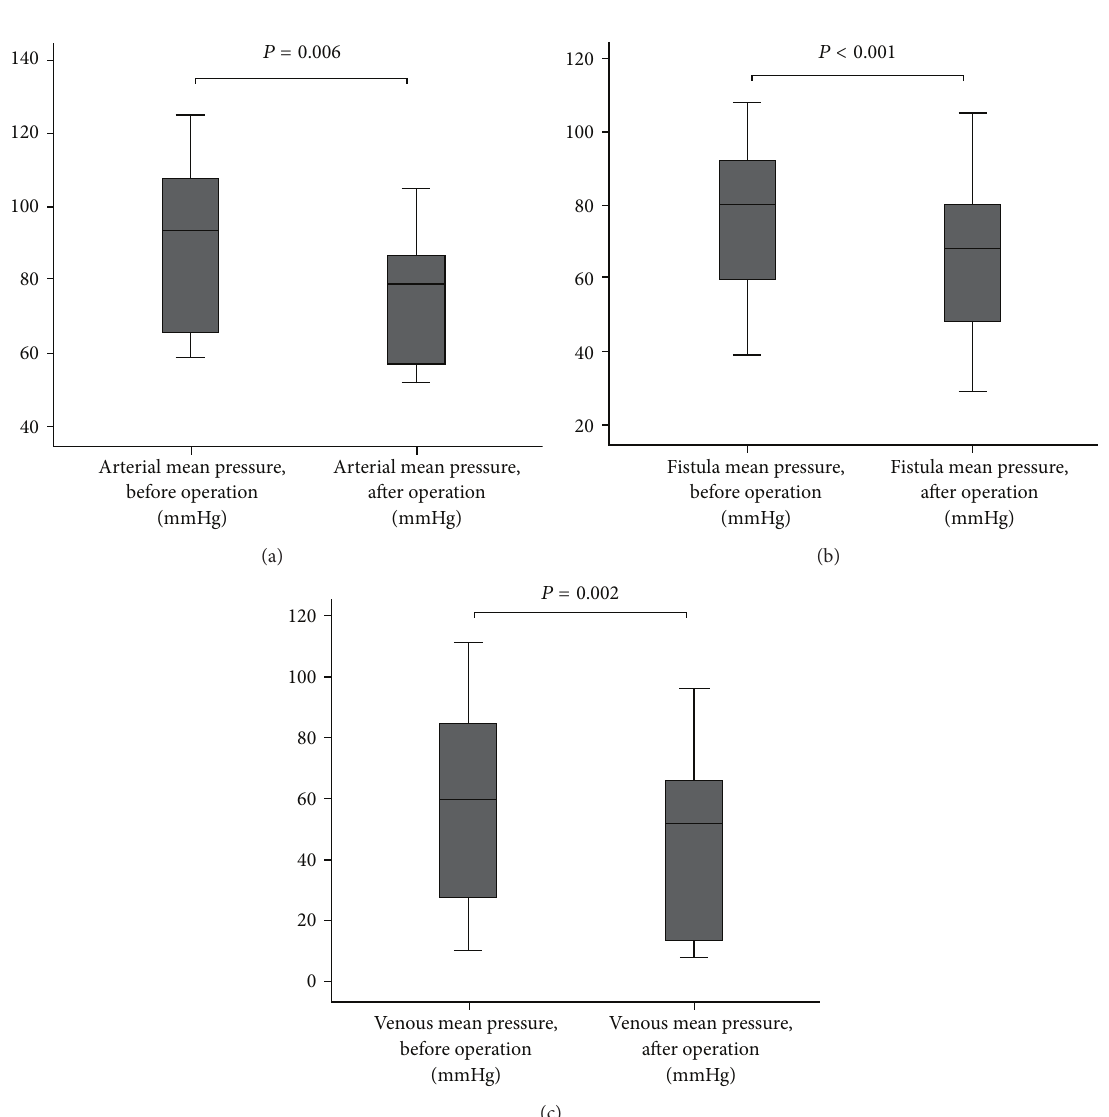
Figure 1: Comparison of arterial mean pressure, venous mean pressure, and fistula mean pressure before and after release